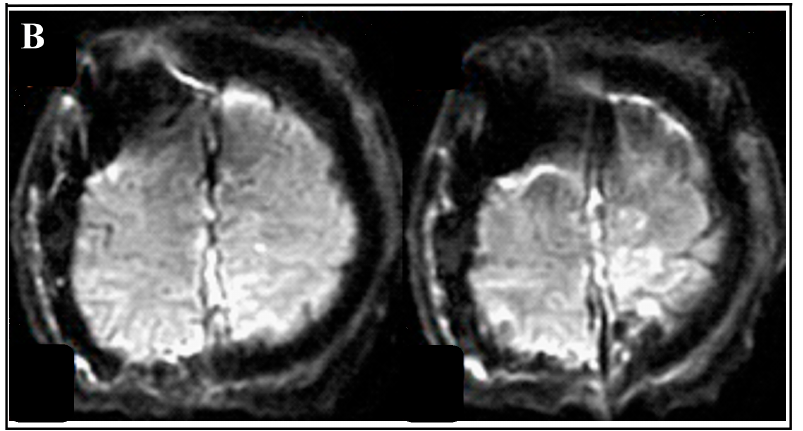
Figure 5. Follow-up brain MRI with diffusion tensor imaging(DTI). ( A ) brain MRI with diffusion- weighted image (DWI) revealed no tract injury or parenchyma damage. ( B ) brain MRI with apparent diffusion coefficient (ADC) revealed no acute